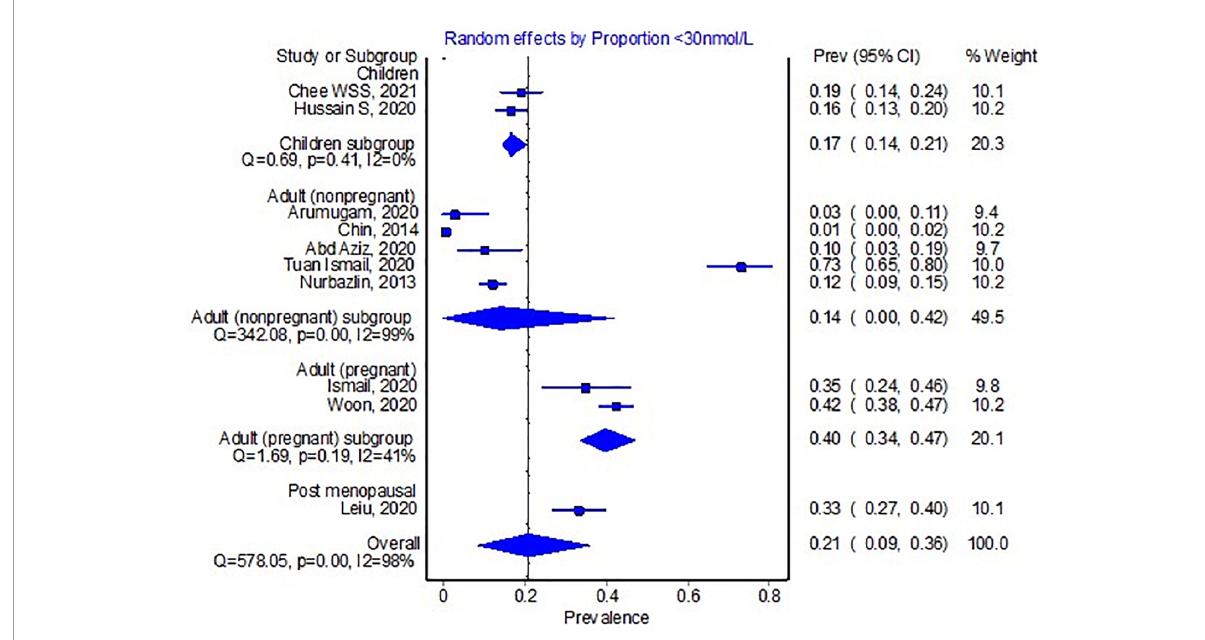
FIGURE2 Pooled proportion of the < 30 nmol/L 25-hydroxyvitamin D